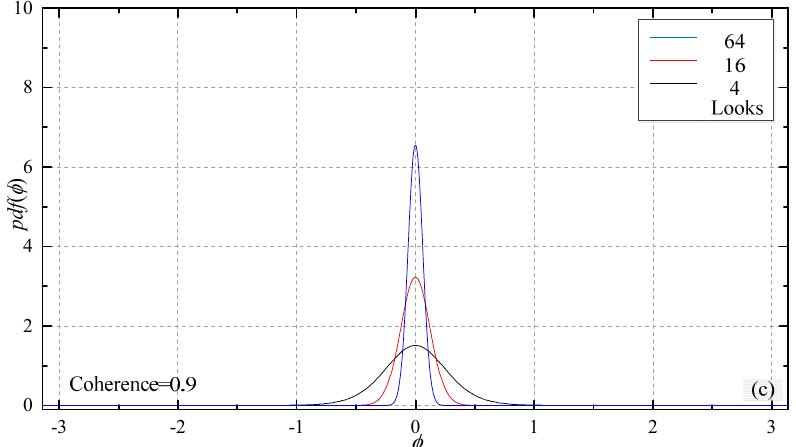
Figure 3. ( a – c ) Probability density function of interferometric noise phase gradient with different coherence and number of looks. The coherence is 0.7, 0.8, and 0.9, respectively. The multi-look numbers of the blue, red, and black lines are 64, 16, and 4.